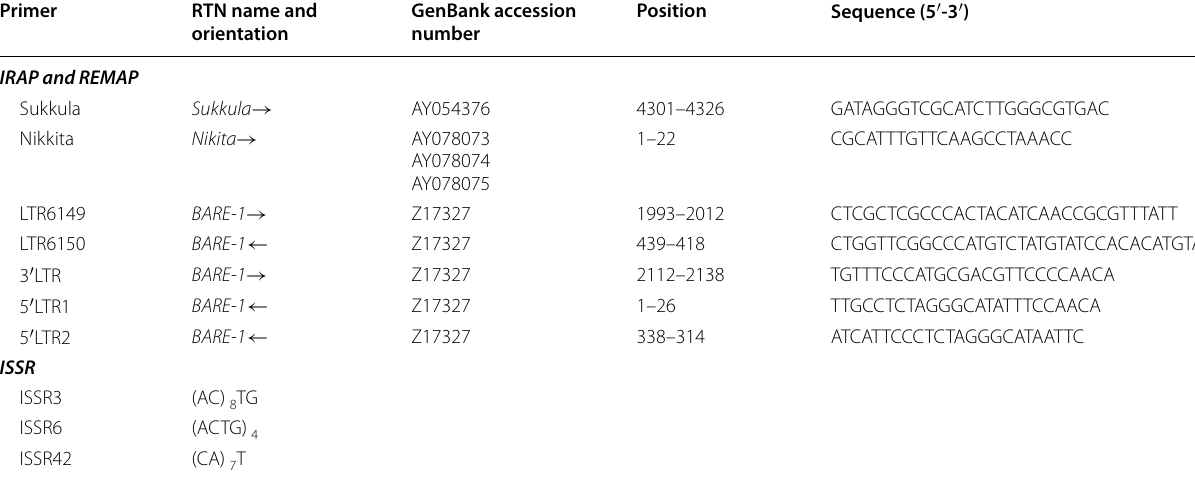
Table 1 Name, retrotransposon source, direction, GenBank accession number, position and sequences of LTR primers, and name and sequences of ISSR